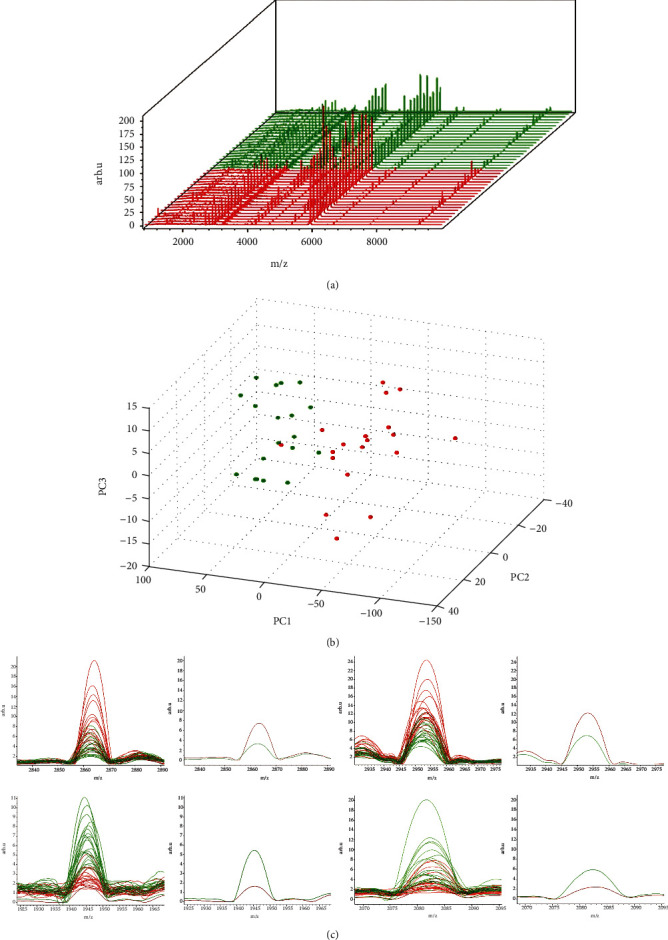
Differential analysis of serum peptides expression profile between healthy and gastric cancer patients. (a) The serum peptide expression profiles of 20 healthy patients and 20 gastric cancer patients were summarized (The horizontal coordinate is mass/charge (m/z), reflecting molecular weight. The ordinate is the sample number: red is the serum sample group of gastric cancer, green is the serum sample group of healthy people). (b) PCA plots of gastric cancer group and healthy group (Red: gastric cancer group; Green: health group). (c) Statistics of 4 differential peptide peaks (left: peptide peaks of all 40 samples; in average peak diagram of the two groups; right: Box diagram. Gastric cancer is red, healthy is green).